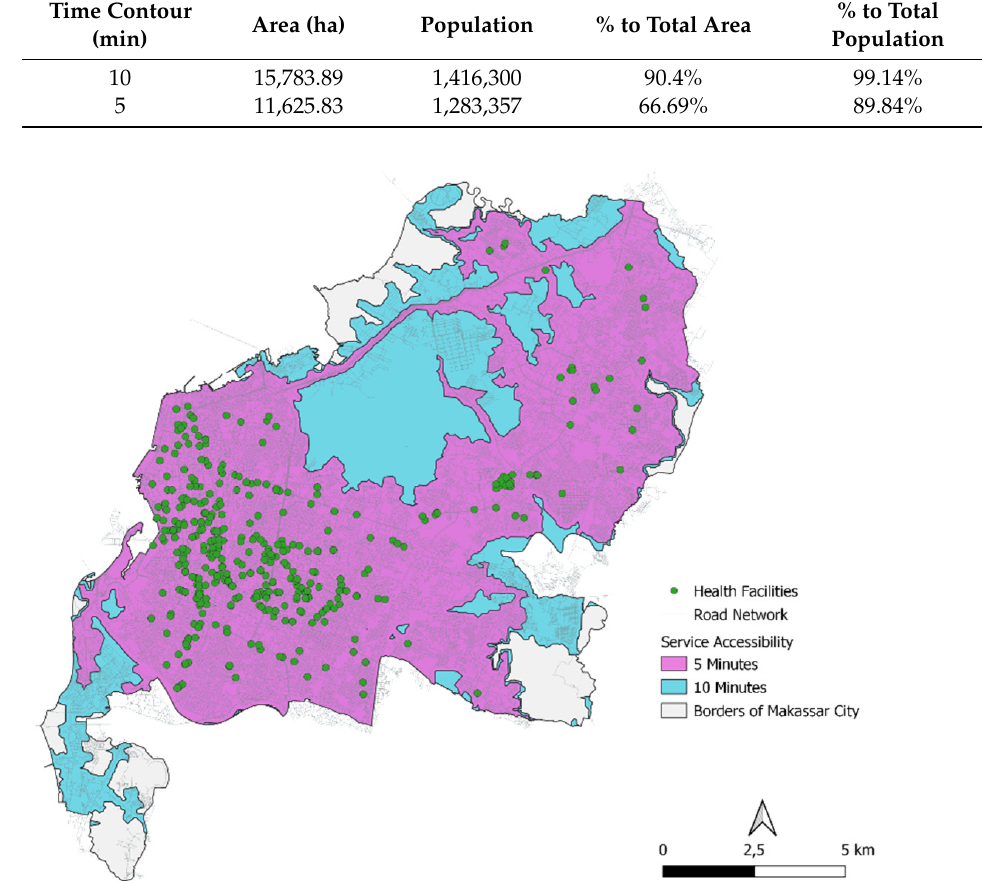
Figure 4. Outreach Map of Health Facilities according to Time Contour.